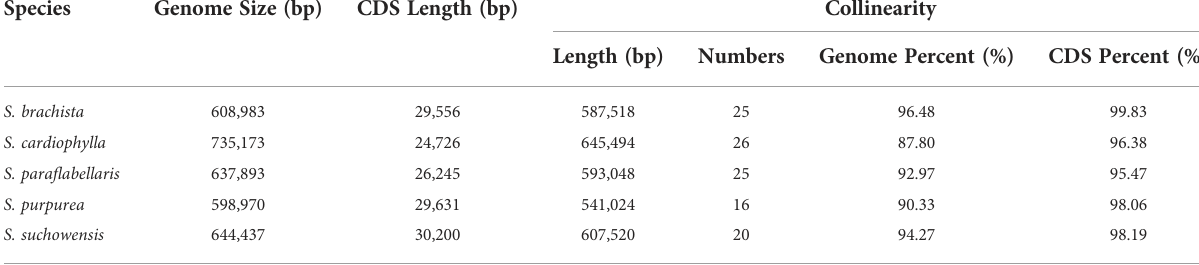
TABLE 3 Collinearity features between S. wilsonii and other fi ve Salix mitogenomes.